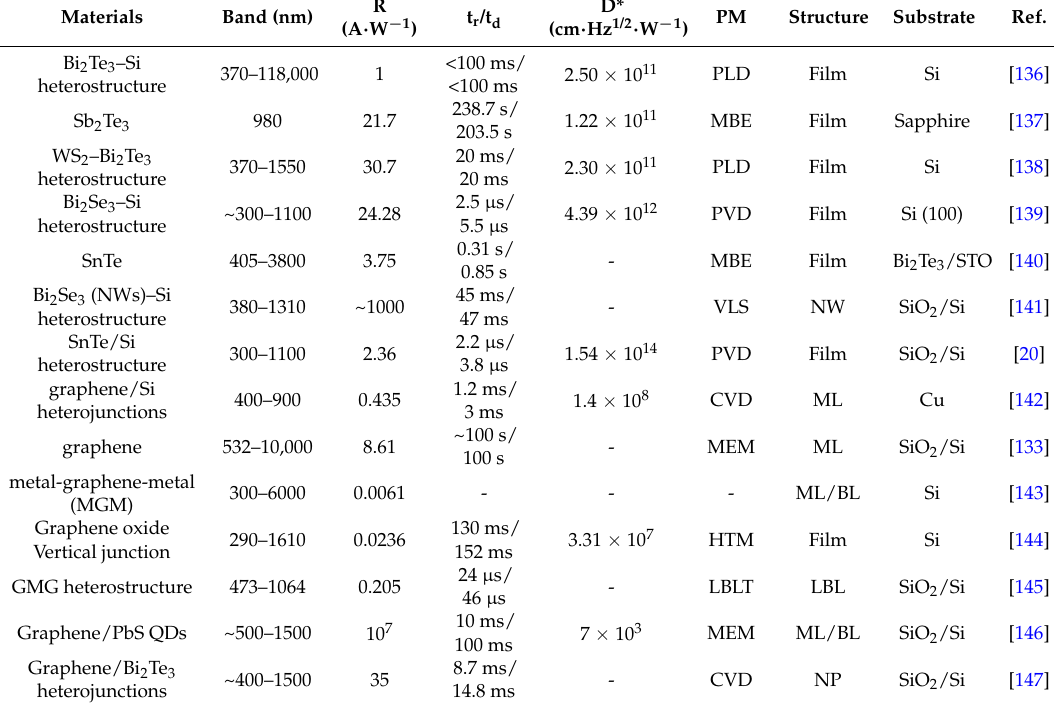
Table 4. Comparison of photodetectors based on TIs and